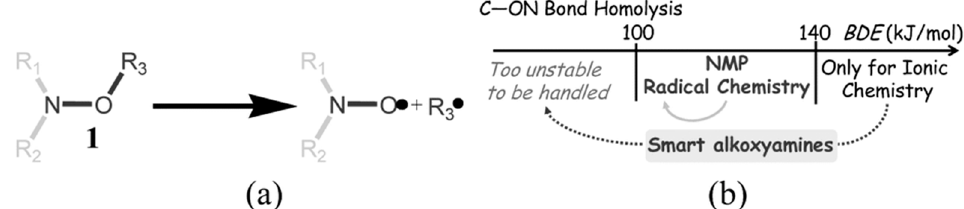
Figure 1. ( a ) The scheme of alkoxyamine hemolysis; ( b ) An outline of a smart alkoxyamine. Reproduced/Adapted from Ref. [18] with permission from The Royal Society of Chemistry.